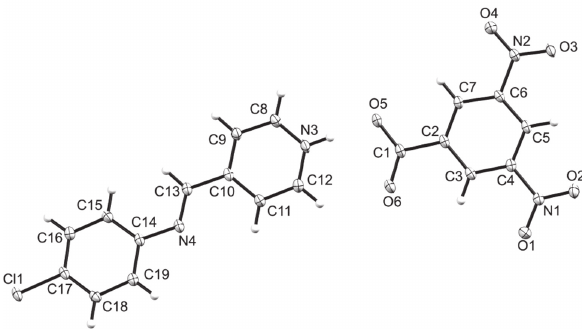
Table 1: Data collection and handling.